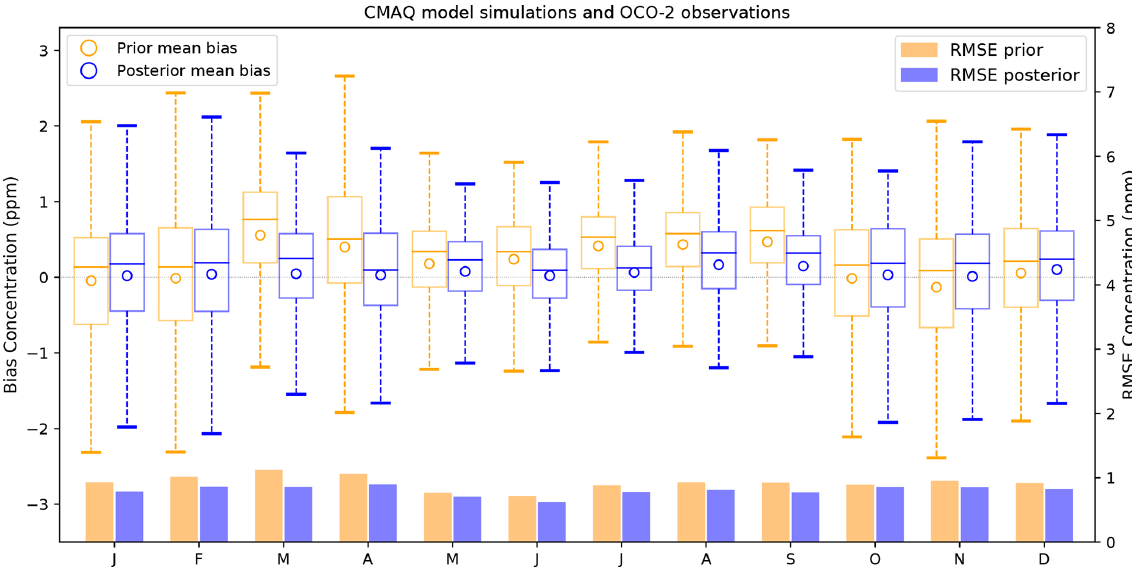
Figure 4. Bias and root mean square error (RMSE) between OCO-2 and the prior and posterior concentrations simulated by CMAQ model. Orange and purple circles represent prior and posterior concentration biases, and orange and blue bars represent the RMSE (Units: ppm). The top edge of the box represents the 75th percentile and the bottom edge represents the 25th percentile. The top and bottom whiskers represent the 95th and 5th